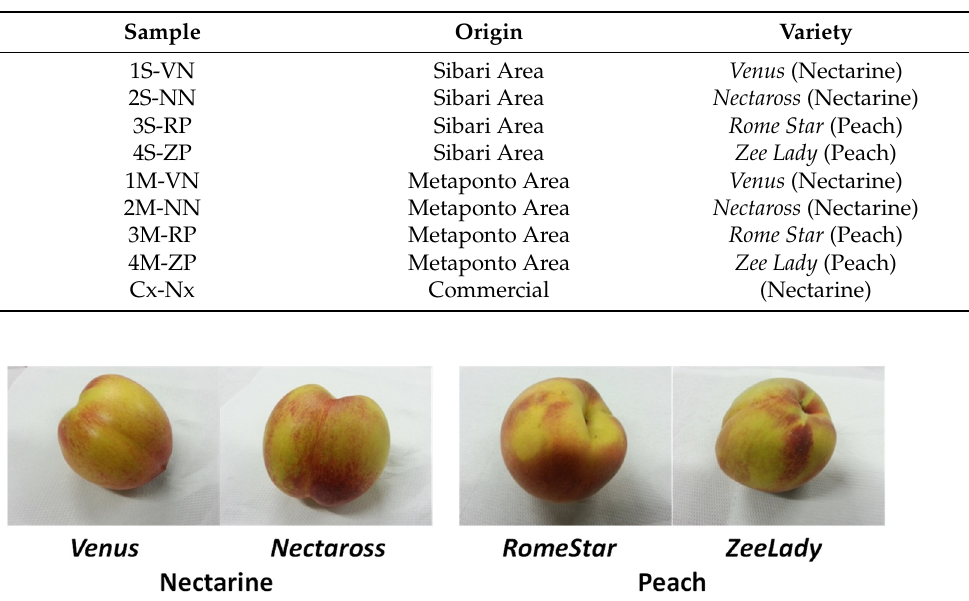
Figure 8. Varieties of peaches and nectarines analyzed in the present